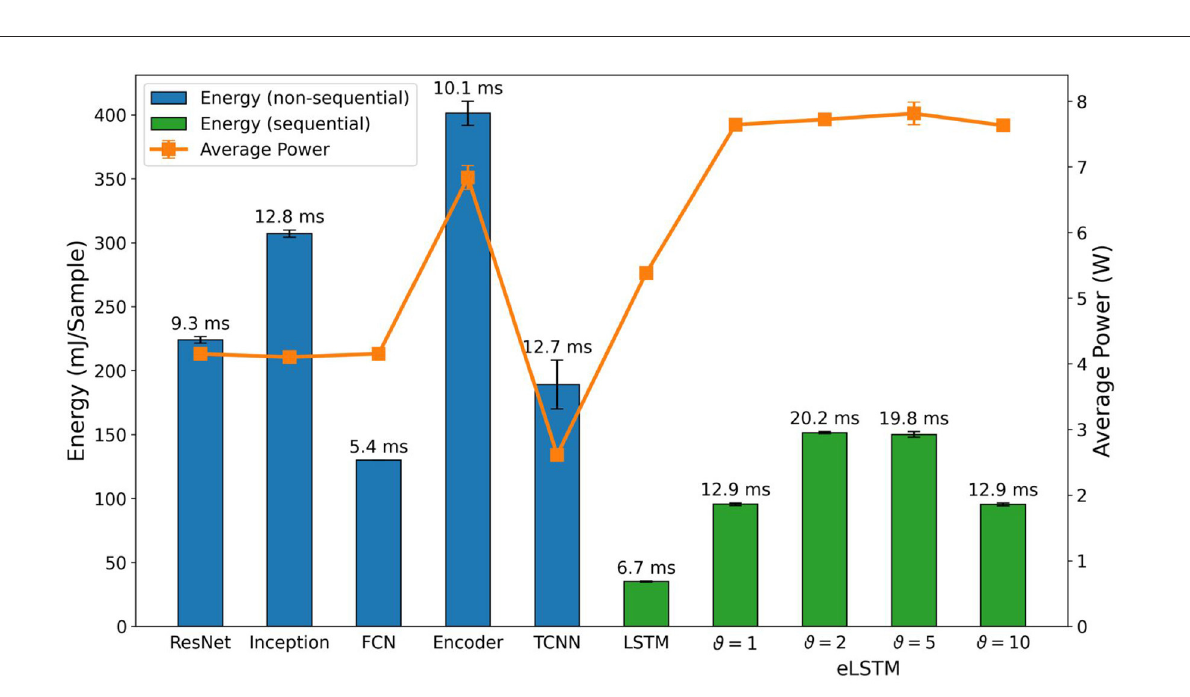
FIGURE8 Comparison of inference metrics from the standard classifiers for frame-based data in terms of energy consumption and average power usage as measured on an NVIDIA Jetson Xavier NX. eLSTM refers to LSTM with event-based input. The label on top of each bar shows the inference time per sample on the corresponding